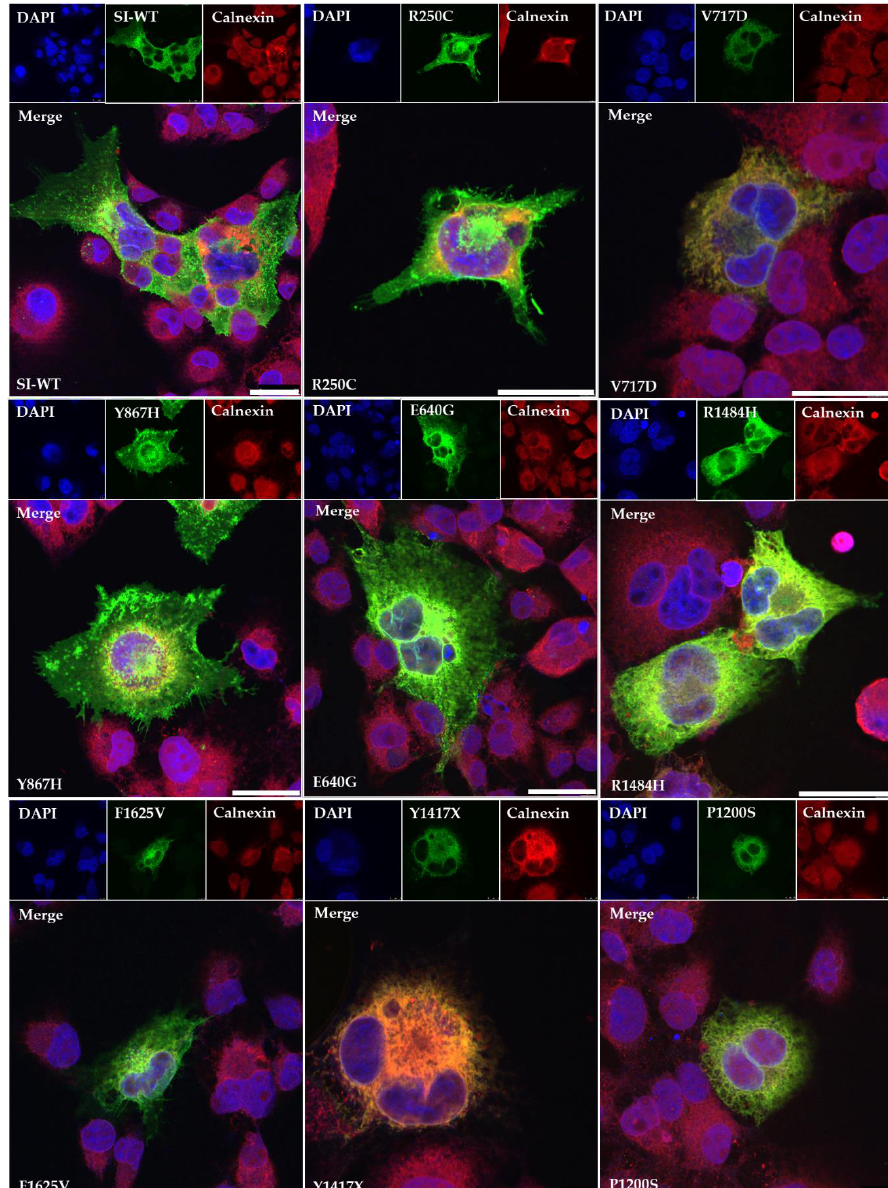
Figure 2. Cellular localization of wild type SI (SI-WT) and SI mutants in COS-1 cells. The SI-WT or Scheme 488. (green). Calnexin was utilized as a protein marker of the ER. Here, rabbit anti-calnexin antibody was used as a primary antibody and goat anti-rabbit IgG (secondary) carrying Alexa flour 568 (red). DAPI labels the nucleus (blue). Bars = 30µm.